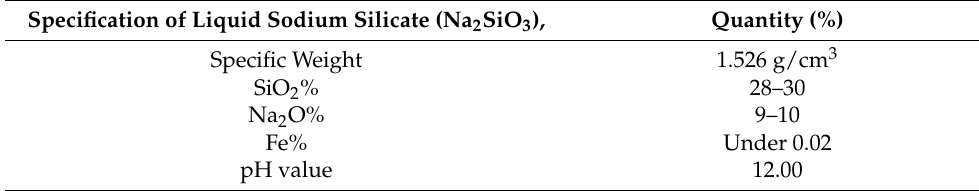
Table 1. Specification of liquid sodium silicate (Na 2 SiO 3